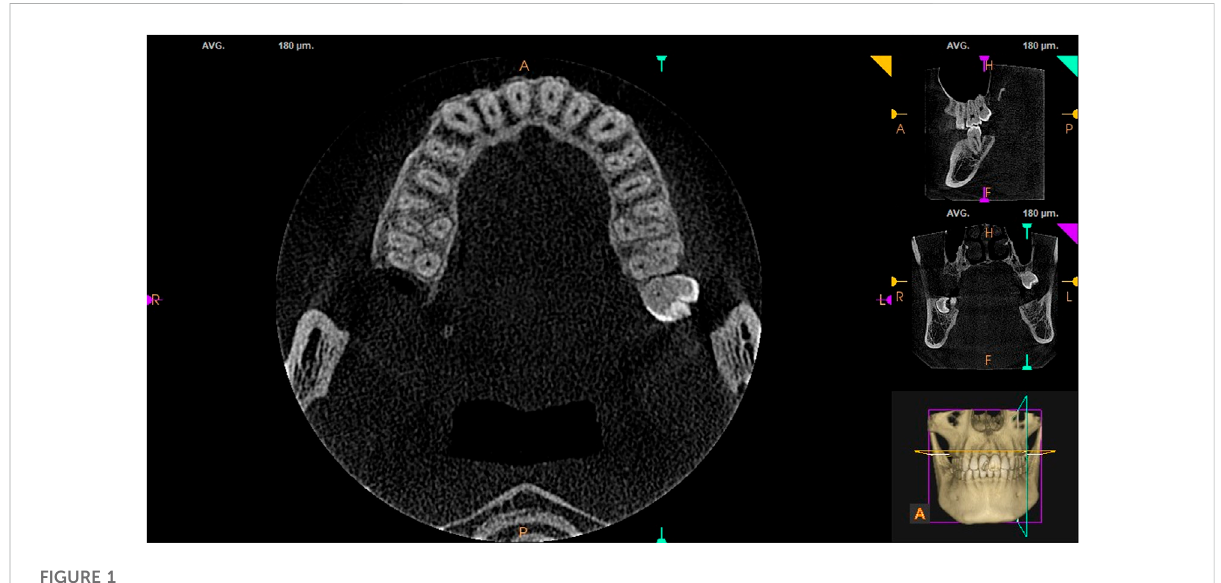
FIGURE 1 MB2 in maxillary fi rst and second